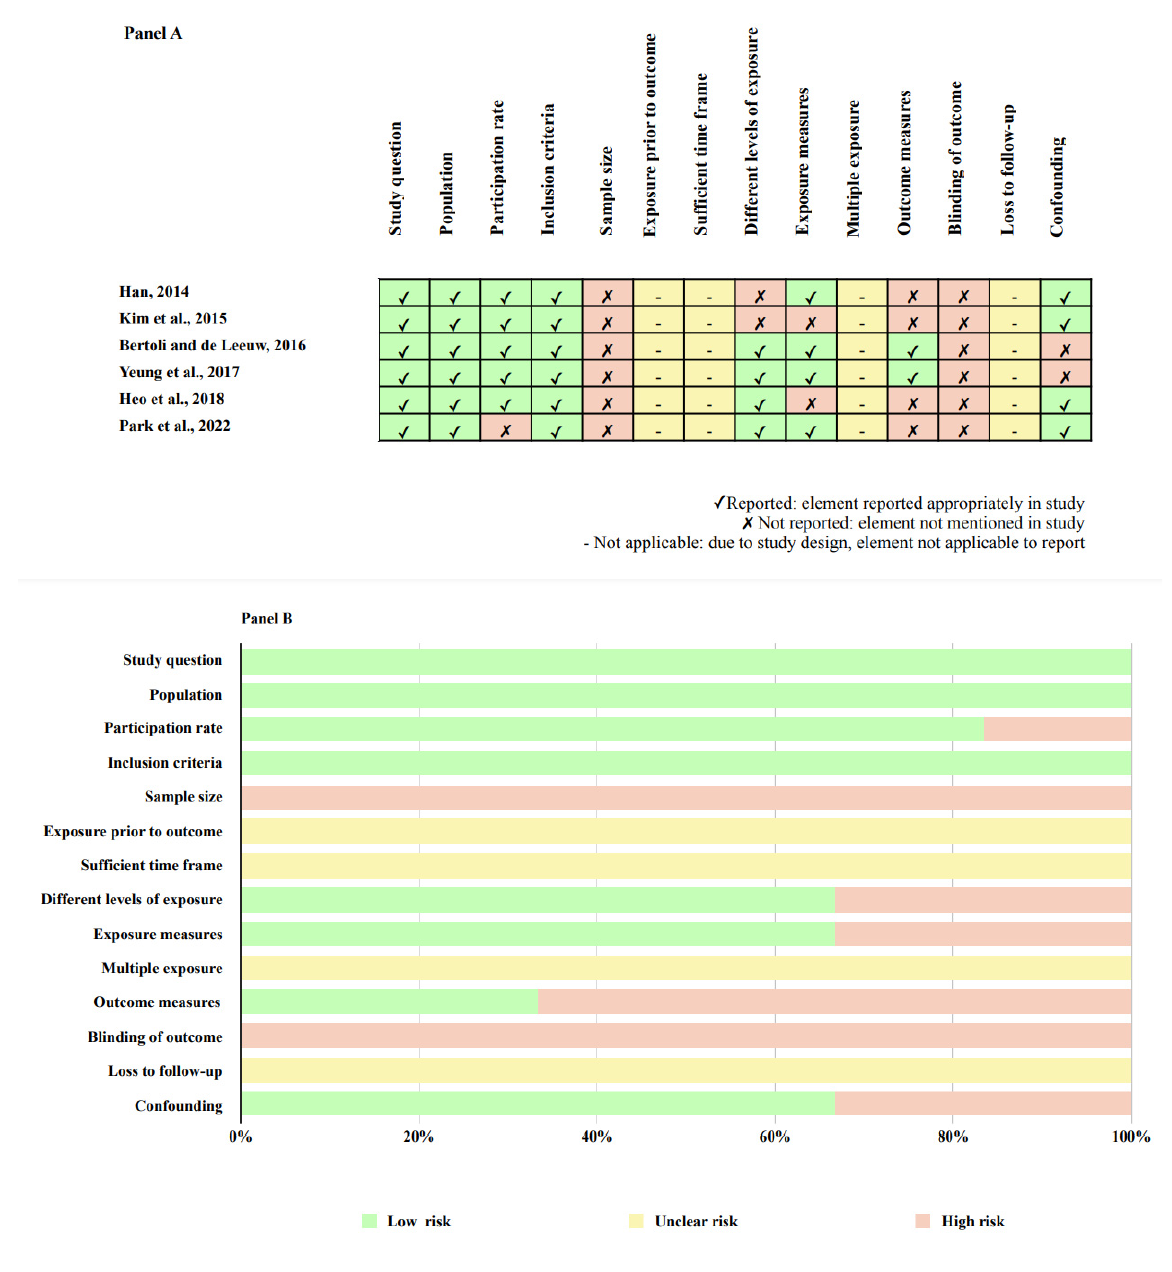
Figure 2. Methodological quality assessment within studies ( Panel A ) [12,16,21–24]; and overall quality assessment across studies ( Panel B ).